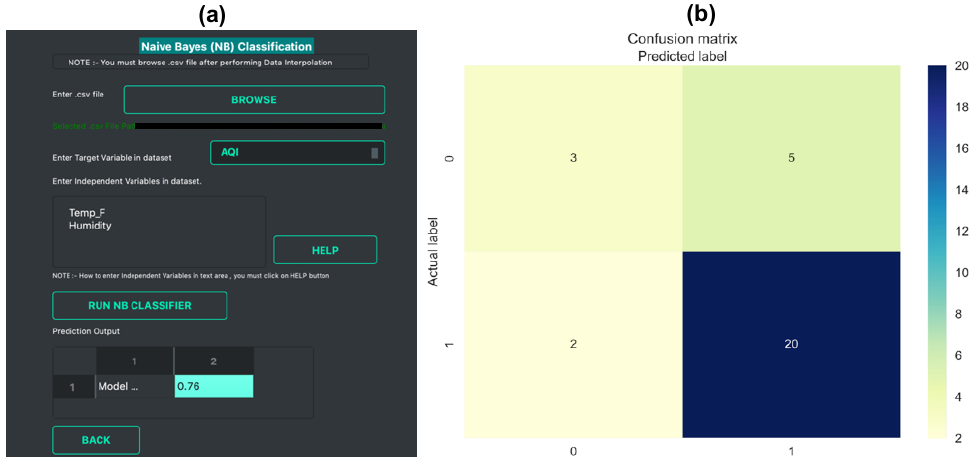
Figure 6. NB Classifier example with outputs: ( a ) Snapshot of NB classifier GUI and ( b ) confu- sion matrix.